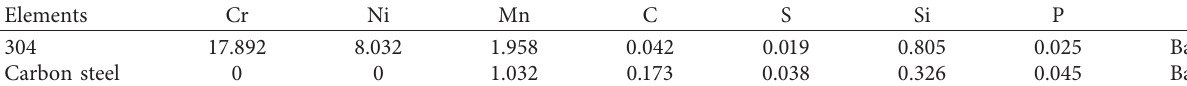
Table 1: Chemical composition of the stainless steel and carbon steel